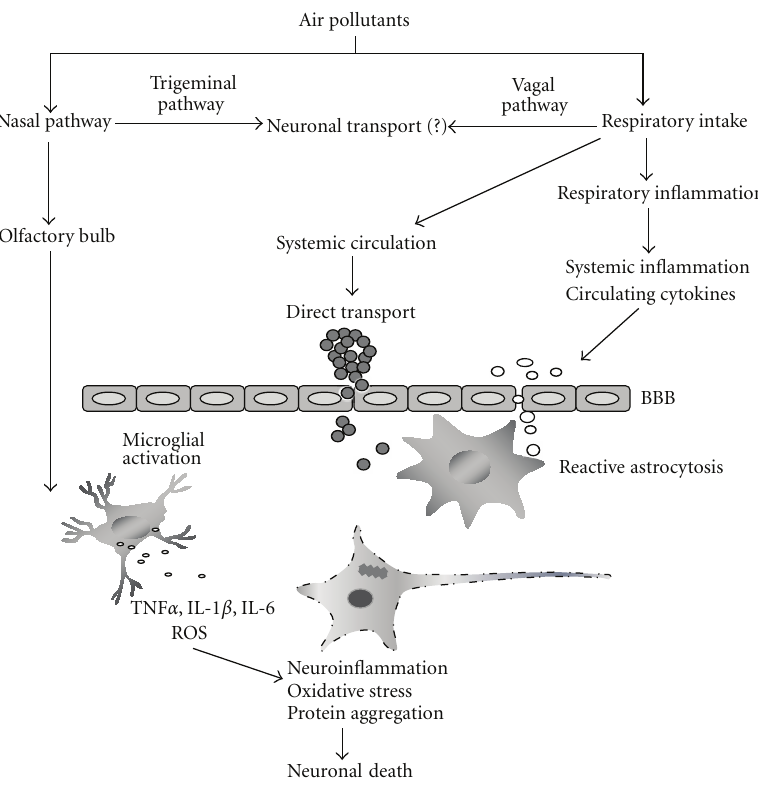
Figure 1: The impact of air pollution on the brain through multiple